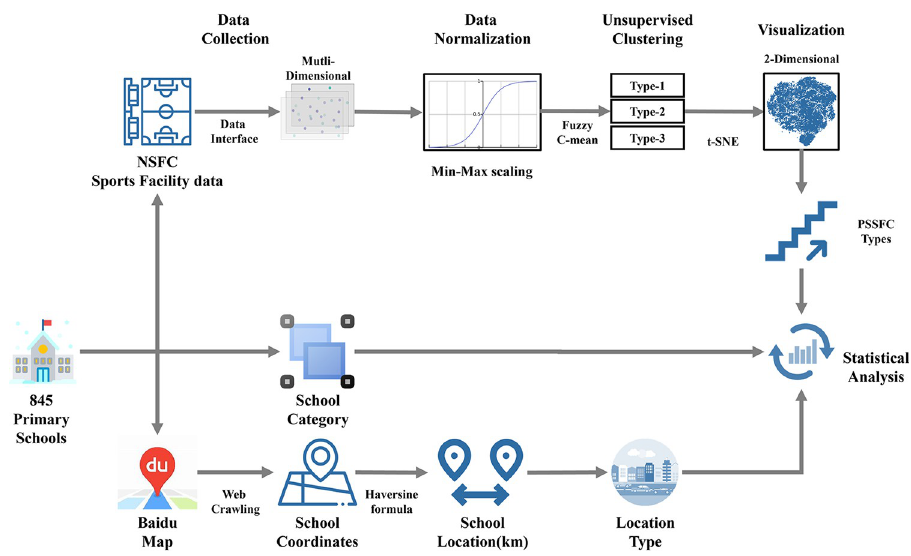
Fig 1. Overview of data processing and modeling pipeline on the assessment of